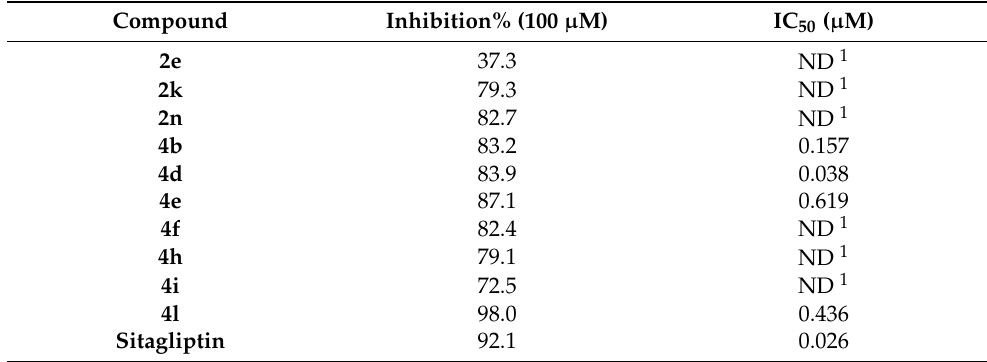
Table 2. DPPIV inhibitory activity of the tested compounds at 100 µ M and IC 50 values obtained in DPPIV assay by fitting the percent enzymatic activity after treatment with the indicated compounds at 0.01, 0.1, 1, 10 and 100 µ M.